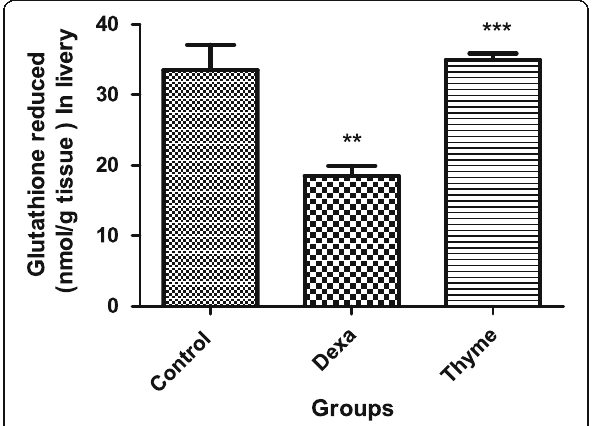
Fig. 8 The defensive role of thyme aqueous extract on liver catalase activity in normal and dexamethasone (DXM)-treated rats. Percentage changes (%) were calculated by comparing normal group with DXM- treated group and pre-treated DXM groups with DXM-treated